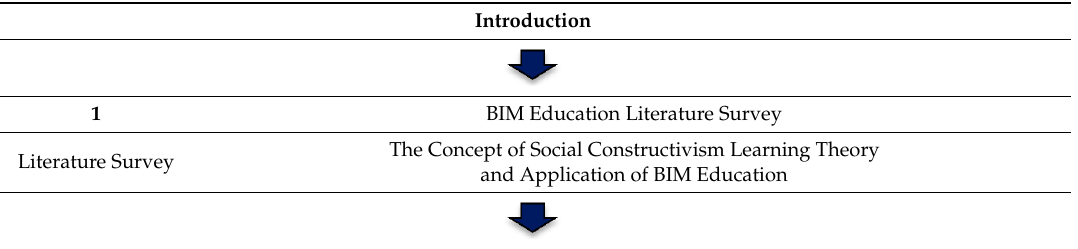
Table 1. Research procedure and